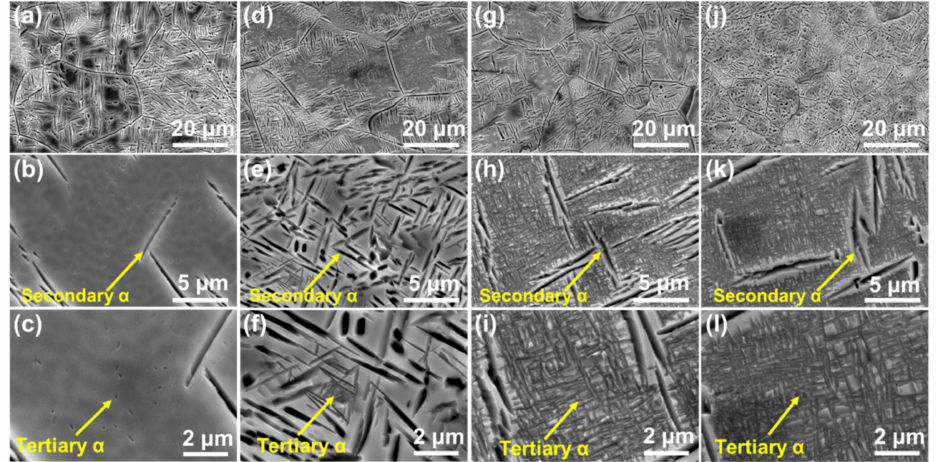
Figure 6. Microstructures of the alloy after HLDA for different time at 550 °C: ( a – c ) 5 min, ( d – f ) 0.5 h, ( g – i ) 2 h, ( j – l ) 4